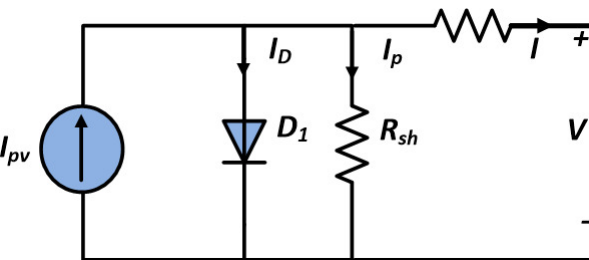
Figure 2. Equivalent circuit for solar cells